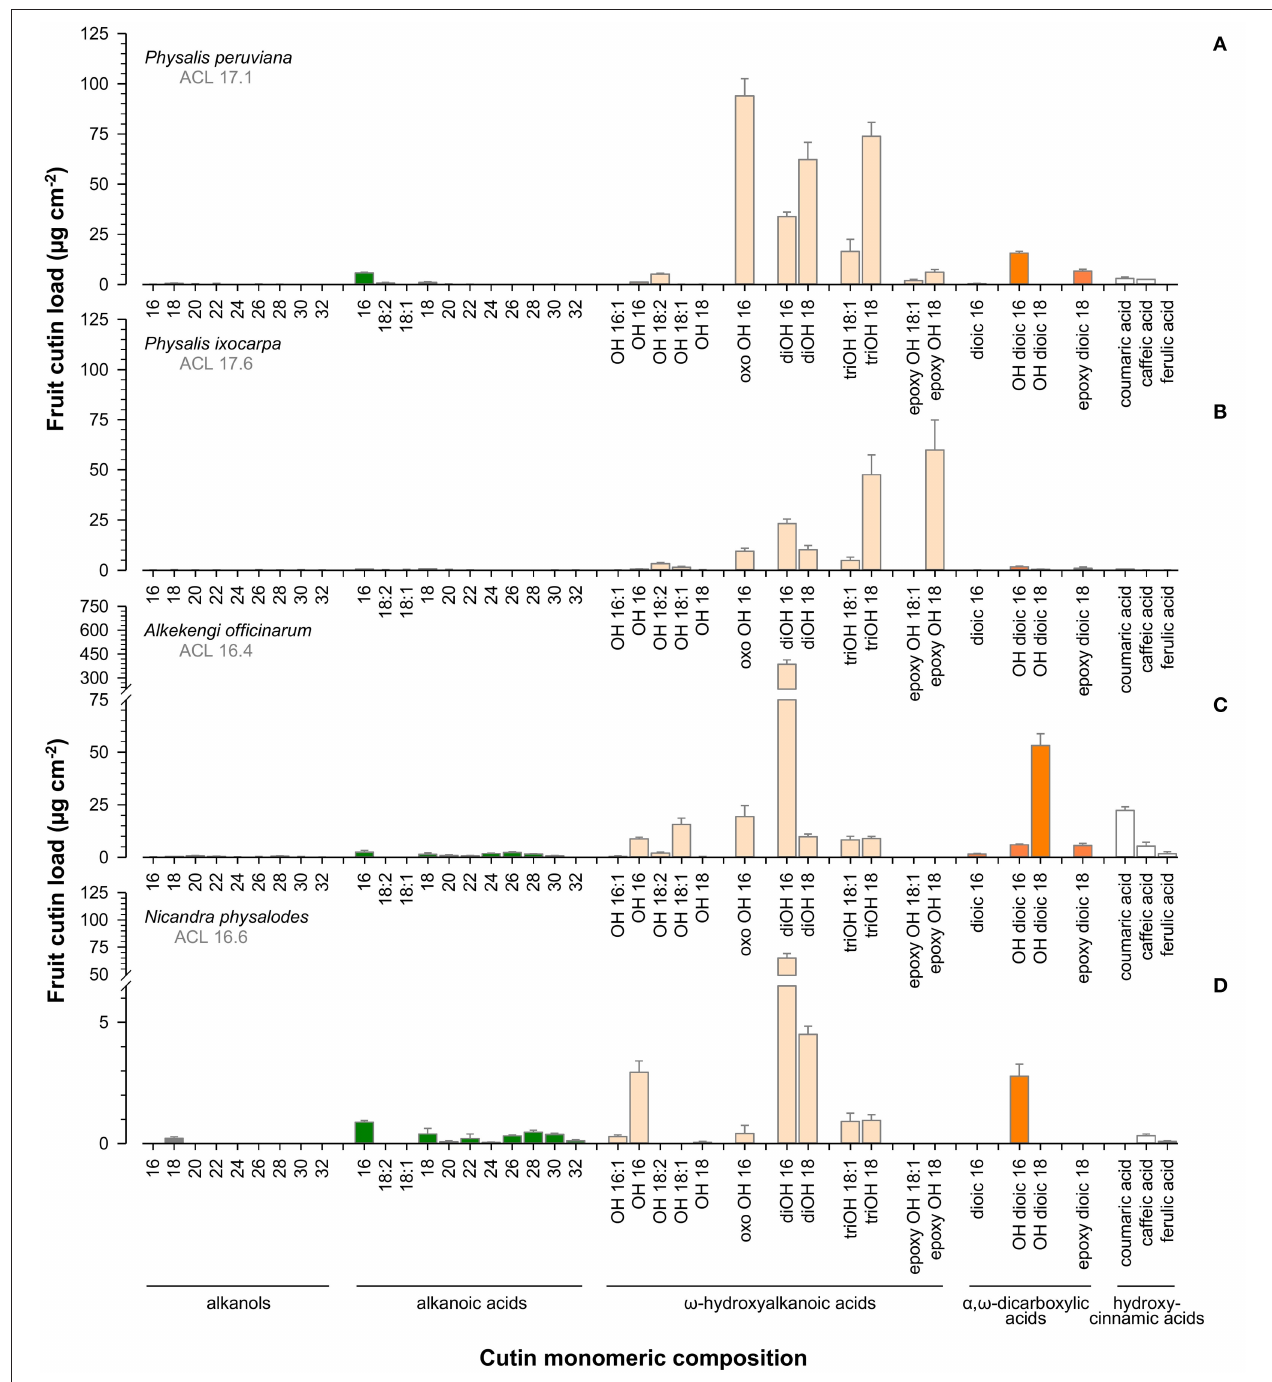
FIGURE 7 | Gas chromatographic analysis of cutin monomeric composition of Physalis ixocarpa (A) , Physalis peruviana (B) , Alkekengi officinarum (C) , and Nicandra physalodes (D) ripe fruits. Average carbon chain lengths calculated for the aliphatic cutin monomers are given (ACL). Data are shown as mean ± SD ( n ≥ 4).